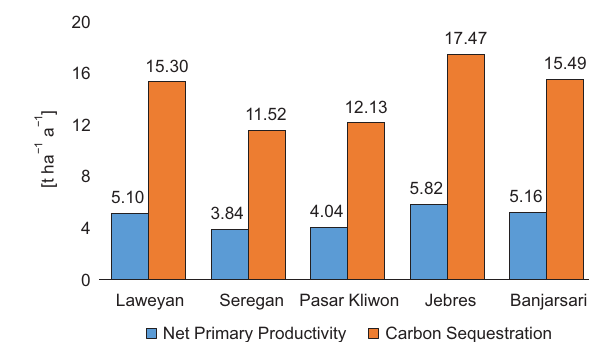
Fig. 7. Annual value of net primary productivity (NPP) and carbon dioxide sequestration in Surakarta